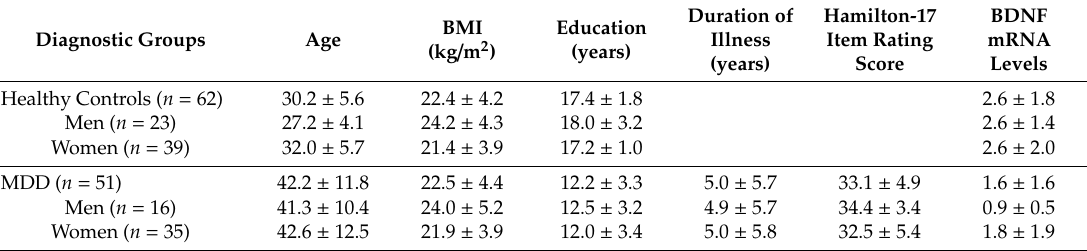
Table 1. Demographic data and serum BDNF mRNA levels at baseline of all